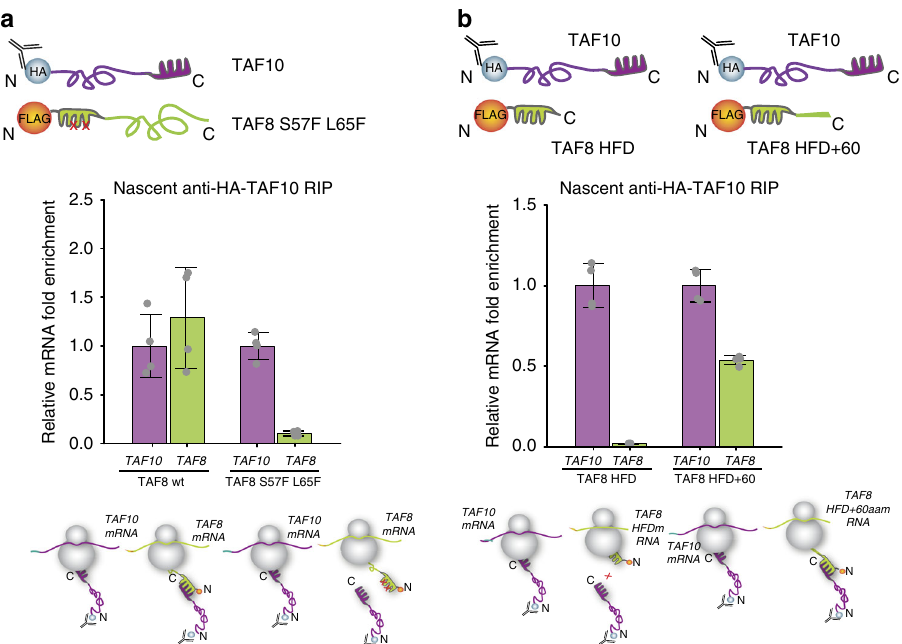
Fig. 3 Protein-protein ID drives co-translational assembly of TAF10 and TAF8. a anti-HA-TAF10 RIP-qPCR of HeLa cells co-transfected with HA-TAF10 and either wild type FLAG-TAF8 (TAF8 wt) or mutant FLAG-TAF8 (TAF8 S57F L65F). b anti - HA-TAF10 RIP-qPCR of HeLa cells co-transfected with HA-TAF10 and either a minimal TAF8 HFD or TAF8 HFD extended with 60 amino acids (TAF8 HFD + 60aa). In panels ( a , b ) relative mRNA fold enrichment is expressed as fold change of TAF8 mRNA (with respect to the mock IP calculated by the formula ΔΔ Cp [IP/mock]) relative to TAF10 mRNA and error bars represent ±SD from two biological and two technical replicates (represented by grey dots). Source data provided as a Source Data